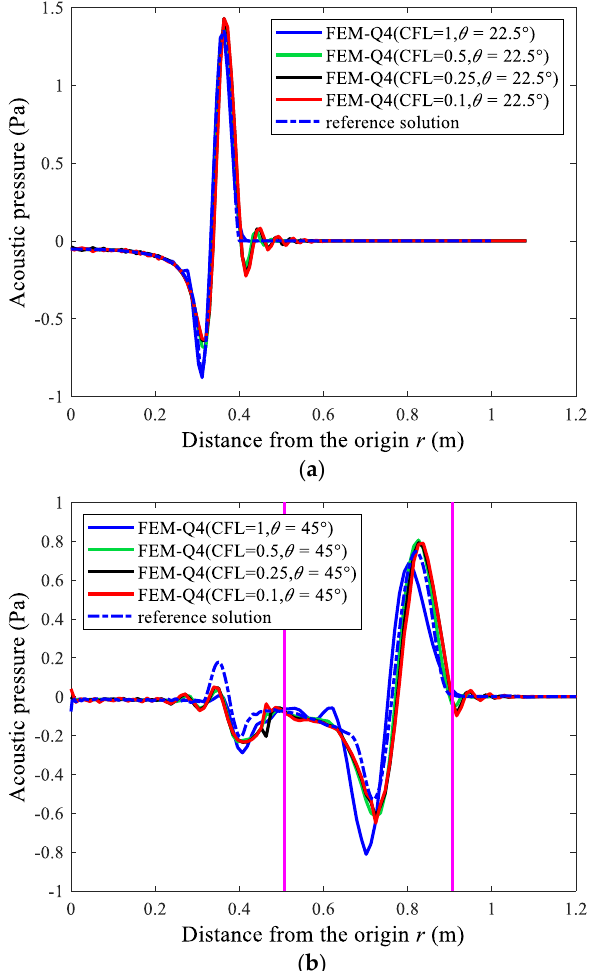
Figure 17. The transient responses of the acoustic pressure distributions at different time points from FEM-Q4 for the two-dimensional scattering problem by using the varying non-dimensional time integration steps: ( a ) t = 0.4 s; ( b ) t = 0.7 s.